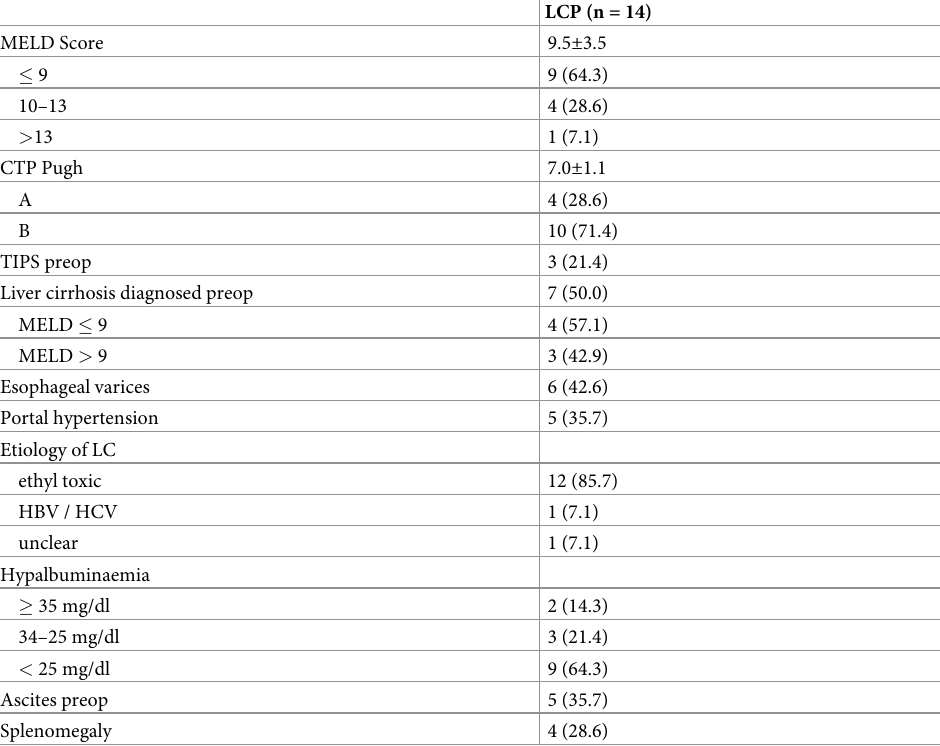
All numbers are indicated as absolute numbers and percentages or mean ± standard